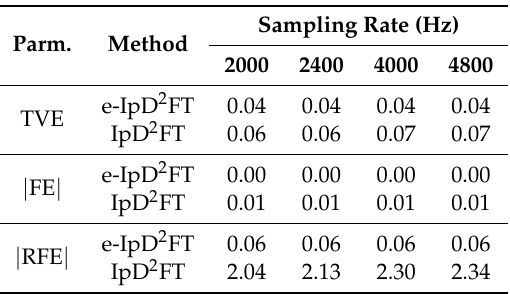
Table 7. Results (maximum values) returned by the e-IpD 2 FT and IpD 2 FT under different sampling rates. The TVE, FE and RFE limits in the standard are the same as in Table 4.